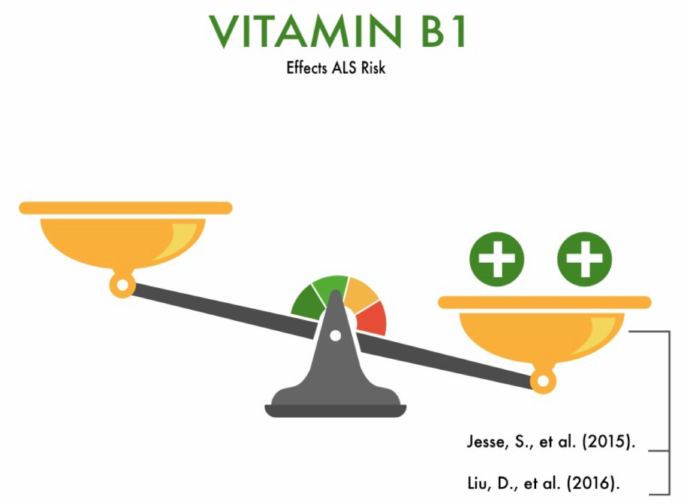
Figure 2. The effect of vitamin B1 on the risk of developing amyotrophic lateral sclerosis